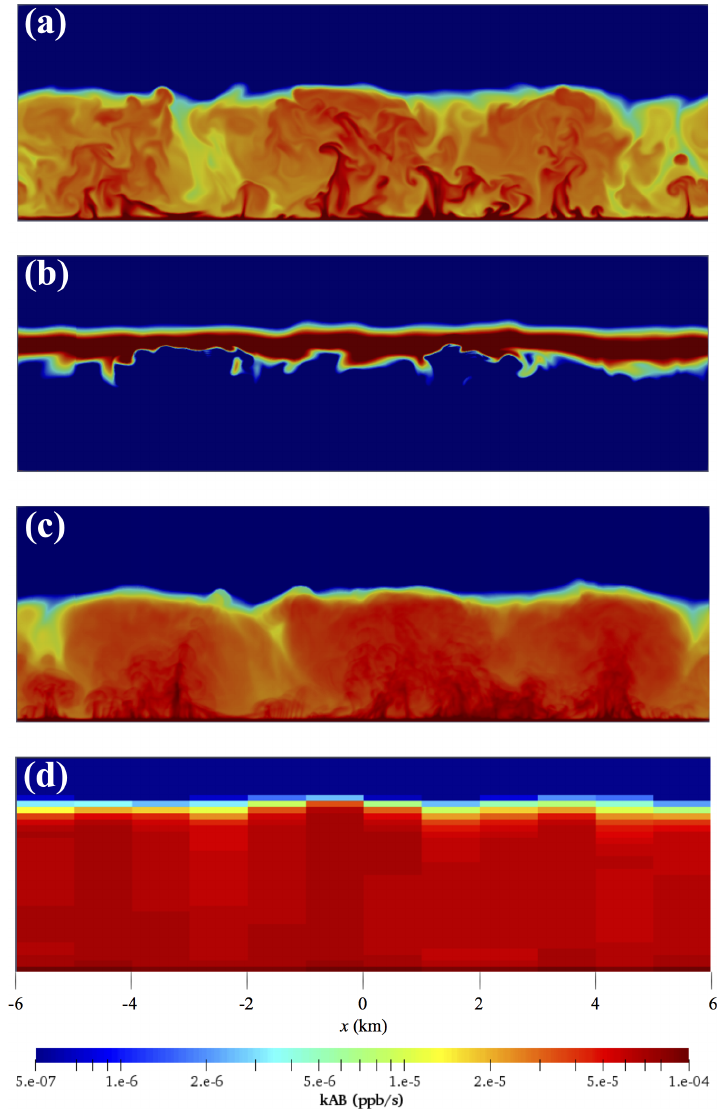
Figure 2. Colour maps of the distribution of the production term ( kAB ) at the end of the simulations with homogeneous emissions for (a) the cases slow-VV05 and (b) slow-mflux. (c) Same colour map for the same case as in (a) but with time averaged for the last 30min of the simulation. (d) Same colour map for the same case as in panel (a) but in the 1km-64lev coarse-grid